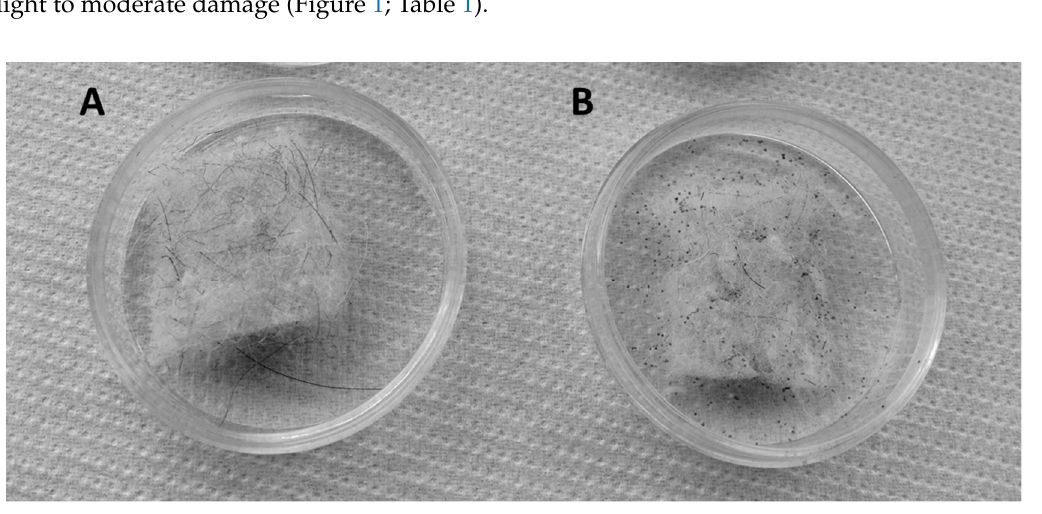
Figure 1. Samples of commercial wool panel ( A ) intact and ( B ) damaged on the surface by the action of clothes moth larvae.